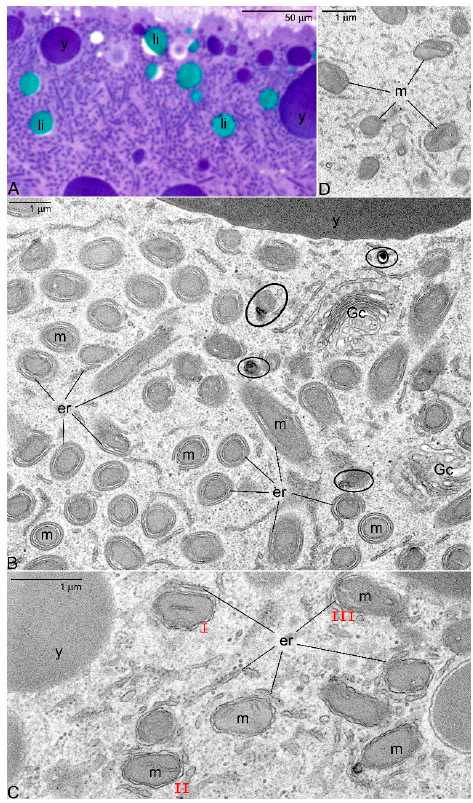
Figure 3. Elimination of mitochondria in vitellogenic oocytes of dermapteran, Hamaxas nigrorufus . ( A ) Semithin section through the subcortical ooplasm. Note numerous profiles of mitochondria. Methylene blue. ( B ) Ultrathin section of the same ooplasm region. Note that nearly all mitochondria (m) are tightly surrounded by endoplasmic reticulum cisternae and are devoid of cristae. Mitochondria displaying signs of degeneration are encircled. TEM. ( C ) The onset of mitophagy: mitochondria exhibit more or less classic morphology and still comprise cristae; the endoplasmic reticulum cisternae (er) start to associate with mitochondria surface; subsequent stages of this association (I–III). TEM. ( D ) Mitochondria in the nurse cell cytoplasm. TEM. Endoplasmic reticulum cisternae (er), Golgi complexes (Gc), lipid droplets (li), mitochondria (m), yolk granules